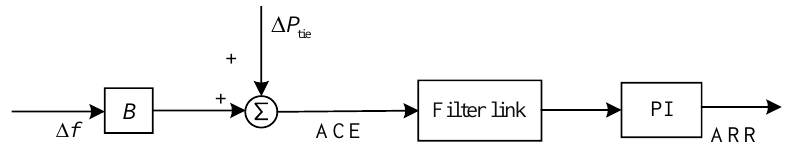
Figure 2. Schematic diagram of ARR signal generation .